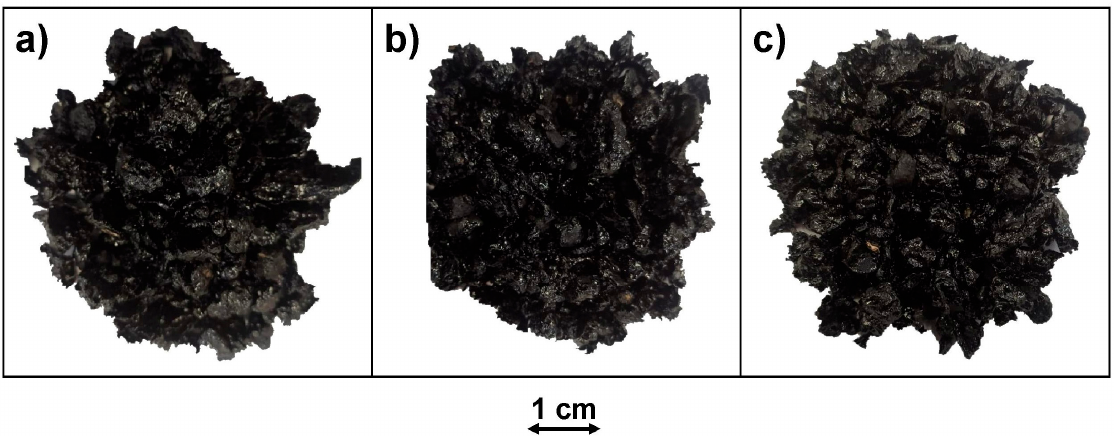
Figure 6. Coating test of bituminous mixtures conformed with ophite coarse and fine aggregate and limestone filler AOFC. ( a ) 6.5% residual bitumen, ( b ) 7% residual bitumen, ( c ) 7.5% residual bitumen.